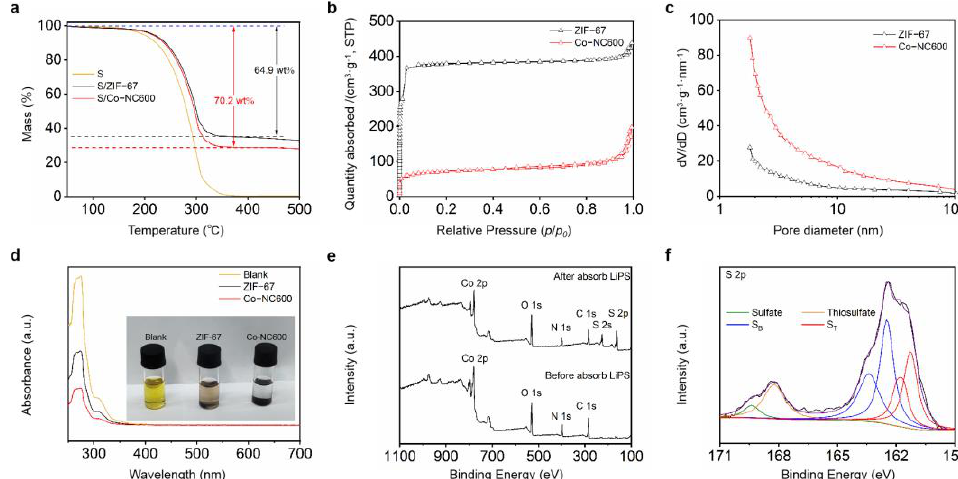
Figure 3. ( a ) TGA curves of S powder and S/Co-NC600; ( b ) N 2 adsorption/desorption isotherms; ( c ) pore size distributions of ZIF-67 and Co-NC600; ( d ) UV–Vis spectra of Li 2 S 6 (pristine, with ZIF-67 and Co-NC600), where inset shows the corresponding photograph after 12 h, ZIF-67 and Co-NC600; ( e ) XPS spectra of Co-NC600 before and after Li 2 S 6 adsorption and ( f ) S 2p spectra of Co-NC600 after Li 2 S 6 adsorption.